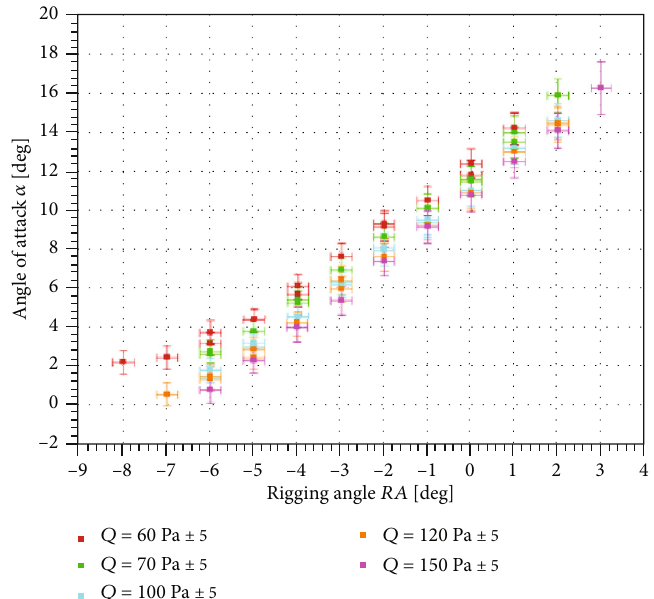
Figure 16: Relationship between RA and angle of attack in the stable fl ight in the wind tunnel